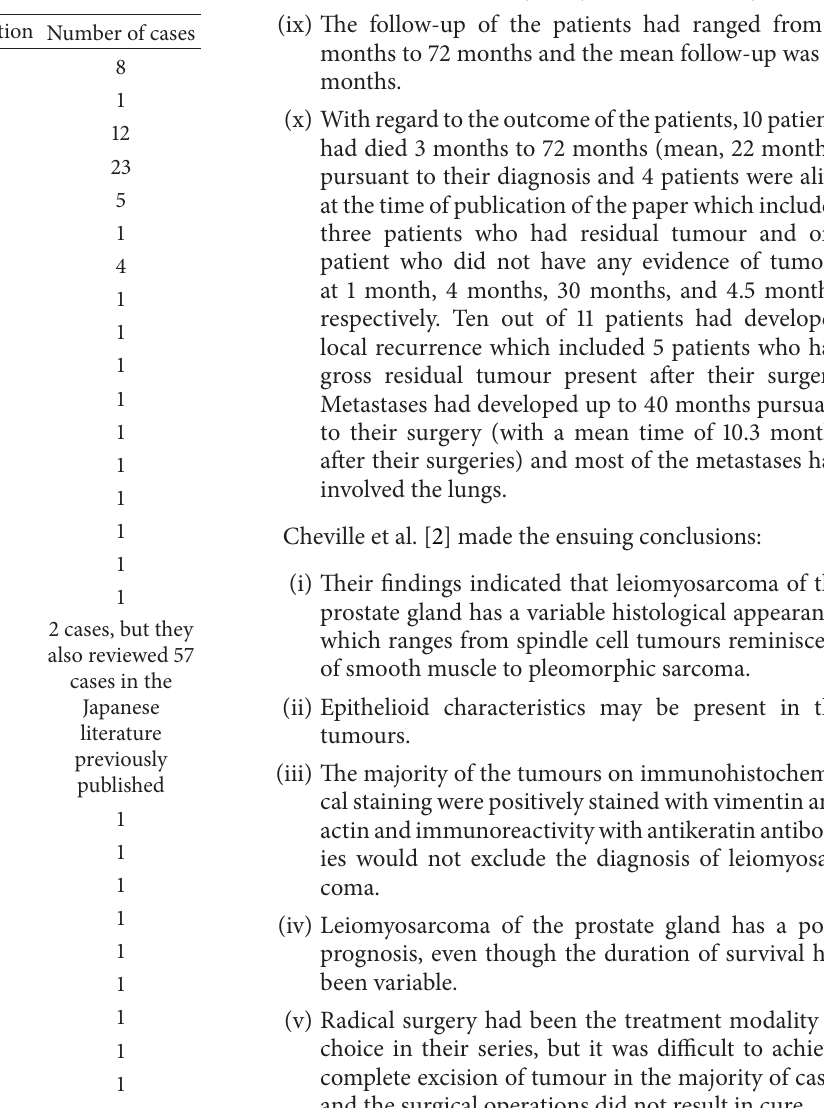
Table 1: List of some of the reported cases of primary leiomyosar- coma of the prostate